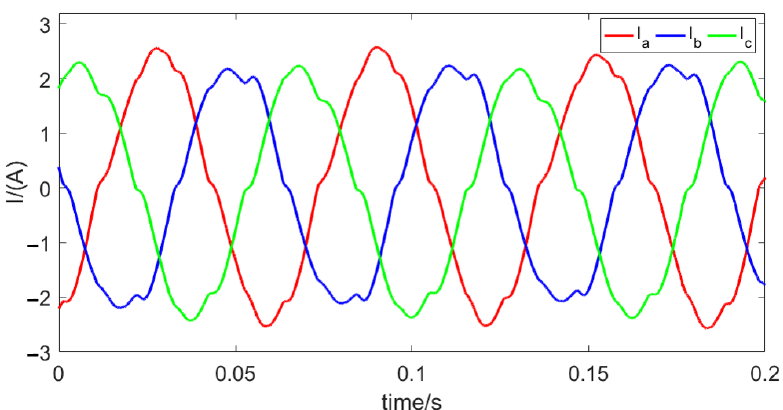
Figure 20. The waveform under the high − order harmonics.